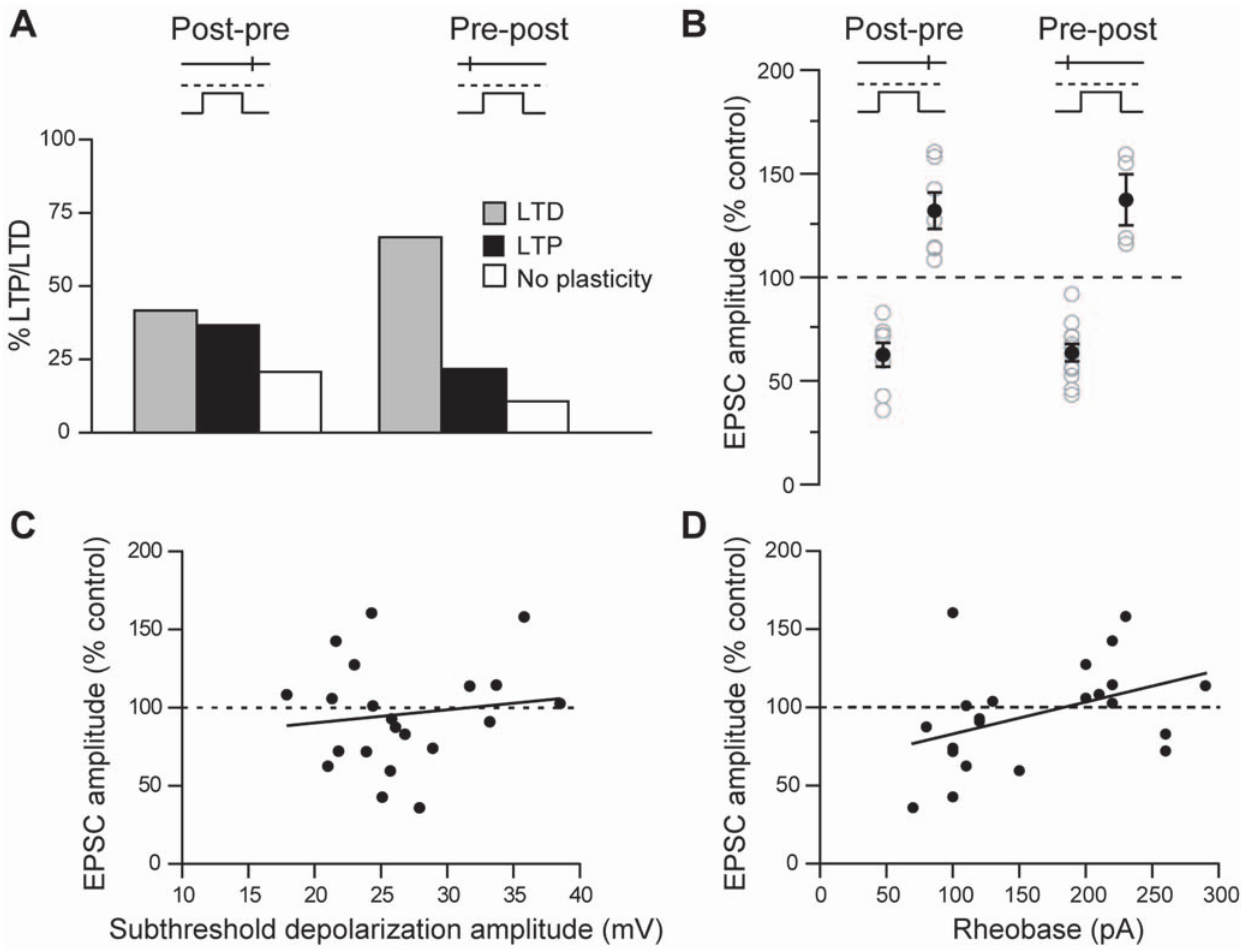
Figure 3. Characterization of SDDP. ( A ) Occurrences of sdLTD and sdLTP. Post-pre sequences (for 2 110 , D t , 0 ms) induced sdLTD and sdLTP with success rates of 42% and 37%, respectively, and pre-post sequences (for 0 , D t , + 110 ms) induced sdLTD (67%) and sdLTP (22%). ( B ) Magnitudes of long-term synaptic efficacy changes induced by post-pre and pre-post SDDP sequences: 2 37.4 6 5.7% and + 32.1 6 8.9% for post-pre sdLTD and sdLTP, and 2 36.4 6 4.7% and + 37.4 6 12.3% for pre-post sdLTD and sdLTP. ( C ) No correlation was found when the magnitudes of long- term plasticity induced by post-pre sequences were plotted against the amplitude of post-synaptic subthreshold depolarizations evoked during SDDP protocol (r=0.147, p . 0.05). ( D ) Rheobase and long-term synaptic plasticity induced by post-pre sequences in MSNs were significantly correlated (r=0.417, p , 0.05).